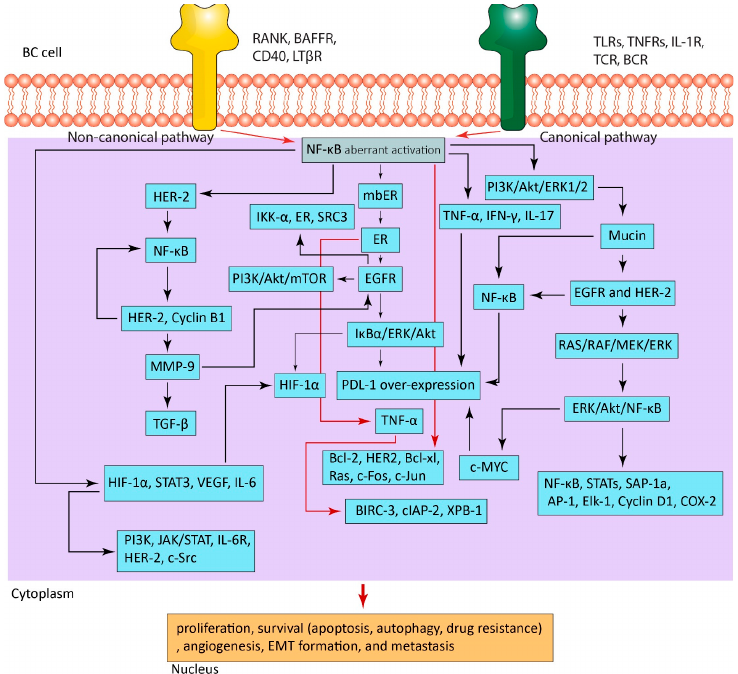
Figure 2. The activation of the NF- κ B in breast cancer microenvironment. NF- κ B interacts with and activates various signaling pathways, which eventually result in BC progression. TLRs, Toll-like receptors; TNFRs, TNF- α receptors; TCR, T cell receptor; BCR, B cell receptor; LT β R, lymphotoxin β receptor; BAFFR, the BAFF receptor; RANK, receptor activator of nuclear factor-kappa beta; BC cell, breast cancer cell; PI3K, phosphoinositide 3-kinase; ERK, extracellular signal-related kinase; HER2, human epidermal growth factor receptor 2; ER, estrogen receptor; NF- κ B, nuclear factor- kappa beta of activated B cell; EGFR, epidermal growth factor receptor; mbER, membrane-bound ER ; SRC3, steroid coactivator 3; MMP-9, matrix metalloproteinase-9; TGF- β , transforming growth factor- β ; BIRC-3, baculoviral IAP repeat-containing 3; cIAP-2, cellular inhibitor of apoptosis protein; XPB-1, X-box binding protein-1; Bcl-2, B cell lymphoma-2; IL-6, interleukin 6; IL-17, interleukin 17; HIF-1 α , hypoxia-inducible factor 1 alpha; VEGF, vascular endothelial growth factor; IL-6R, inter- leukin 6 receptor; EMT; epithelial-to-mesenchymal transition; PD-L1, programmed cell death recep- tor 1 ligand; IFN- γ , interferon gamma; STAT, signal transducer and activator of transcription. Note: For more information, please see the text. 4.2. NF- κ B Activates HIF-1 α in BC When the oxygen (O 2 ) levels in the tumor microenvironment fall below 5–10 mmHg, it is referred to as hypoxia, which is characterized by discrepancies in O 2 absorption and consumption induced by the uncontrolled proliferation of cancer tissues [79]. It should be noted that hypoxia is a characteristic of many solid tumors, including BC, and that it is connected to cell survival, proliferation, angiogenesis, and metastasis [79]. Importantly, hypoxia promotes the activities of clinically signi fi cant transcription factors (HIFs), which are represented by: (1) a heterodimer structure composed of O 2 -senstive α subunit-de- pendent transcription factors ― HIF-1 α , HIF-2 α , and HIF-3 α― containing an O 2 -